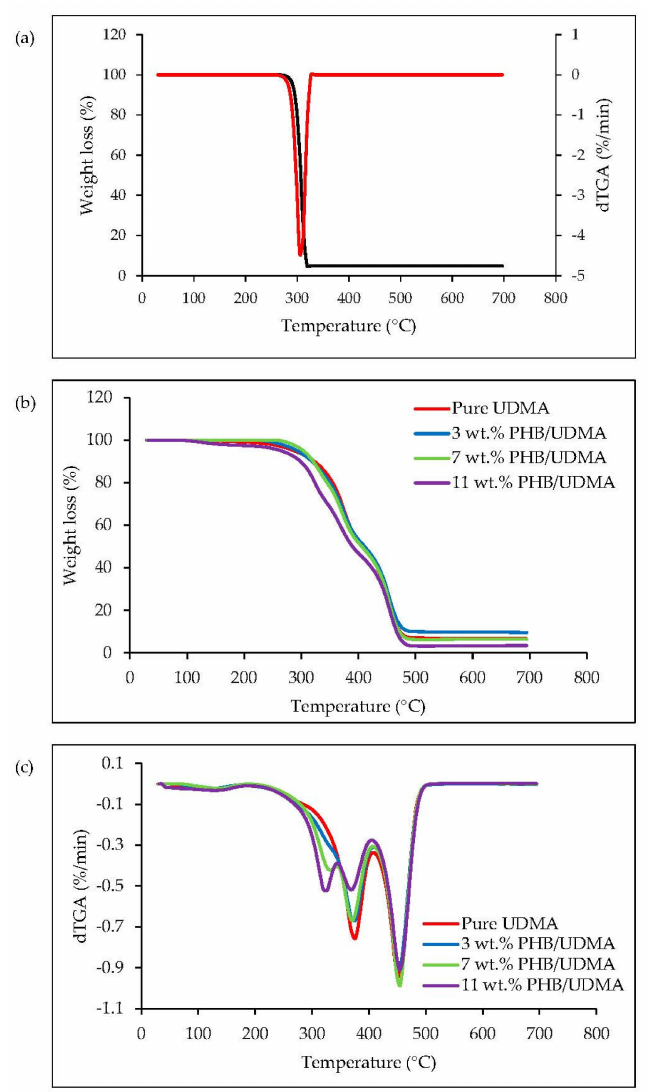
Figure 11. The thermal graphs of: ( a ) TGA and dTGA of PHB powder; ( b ) TGA curves of 3D printed PHB/UDMA and ( c ) dTGA curves of 3D printed PHB/UDMA.